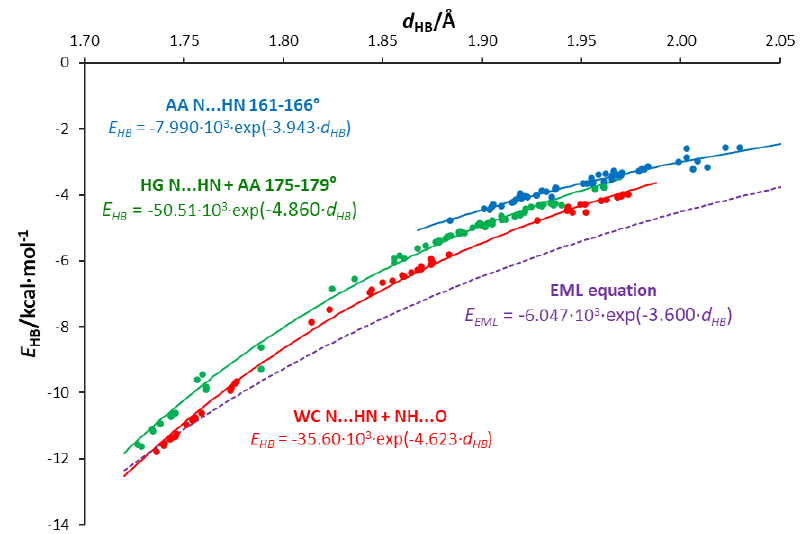
Figure 8. Dependences of the H-bond energies, E HB , on their lengths, d HB , in the studied adenine-uracil and adenine-adenine base pairs.